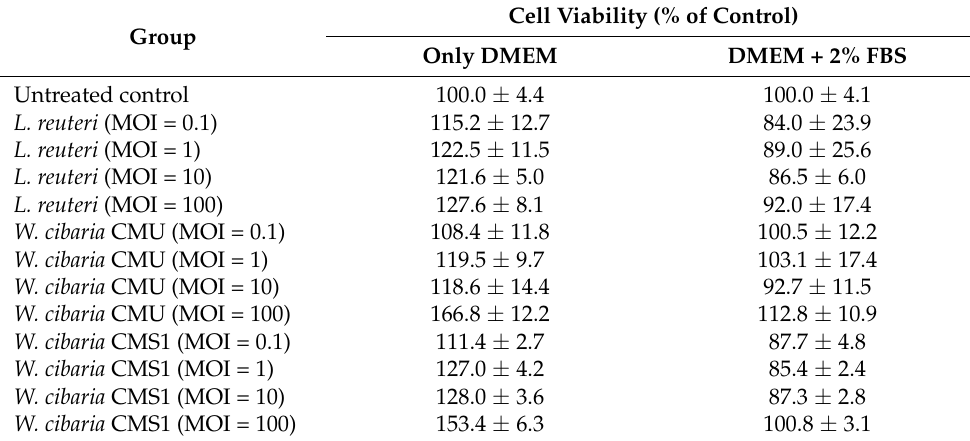
Figure 3. Comparison of antibacterial activities between oral probiotics against S. mutans Ingbritt ( a – f ) and P. gingivalis ATCC 33277 ( g – l ). Each horizontal line was inoculated with the tested pathogens and the vertical line was inoculated with 10-fold serial diluted oral probiotics. The white arrows indicate areas of poor pathogen growth and potent antibacterial activity of oral probiotics. ( a , g ) L. reuteri ; ( b , h ) L. paracasei ; ( c , i ) L. gasseri ; ( d , j ) S. salivarius ; ( e , k ) W. cibaria CMU; ( f , l ) W. cibaria CMS1. Table 2. Cell viability of HGFs treated with oral